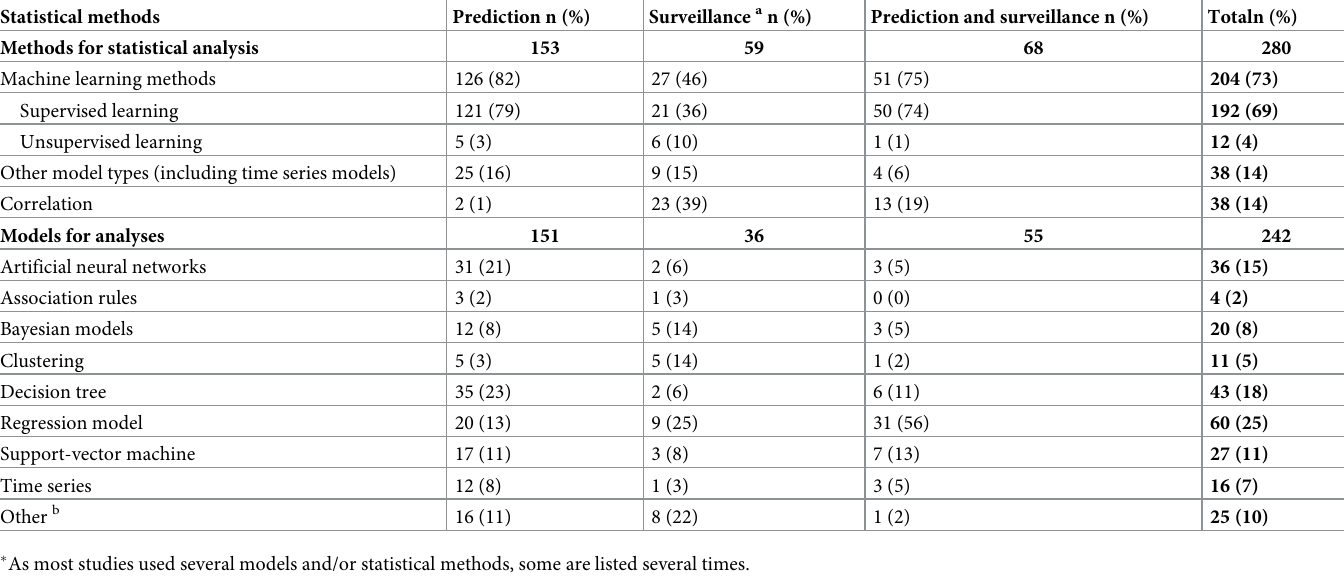
Table 3. Statistical methods and models used in the selected studies depending on the study aim �